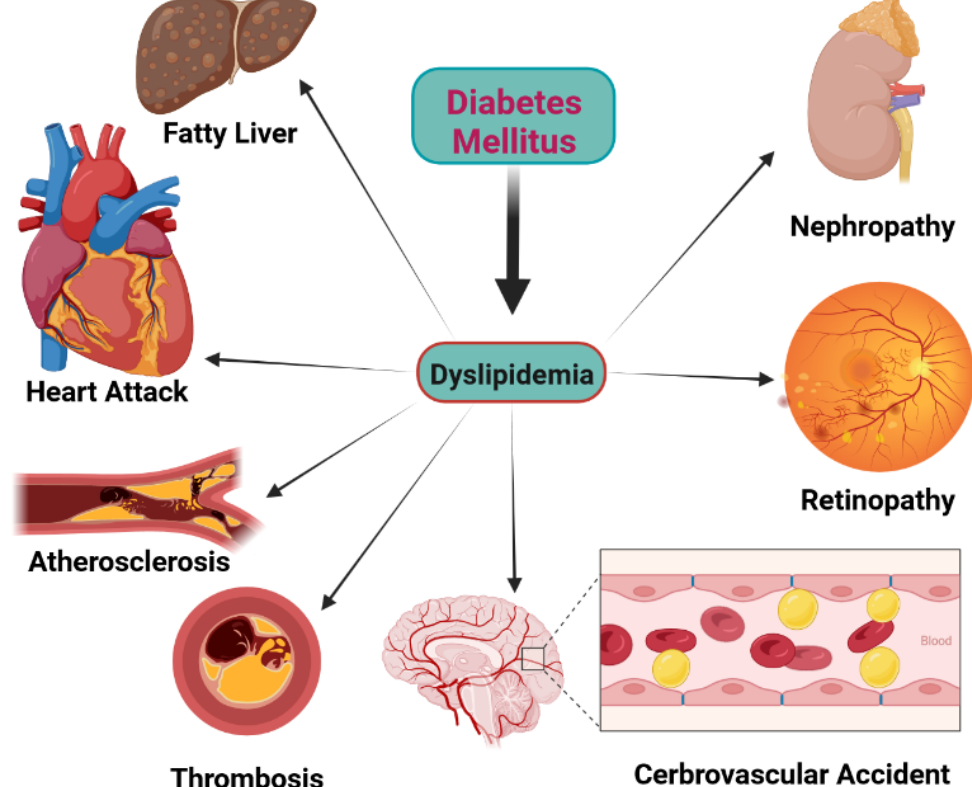
Figure 3. The main forms of dyslipidemia-induced diabetic complications.